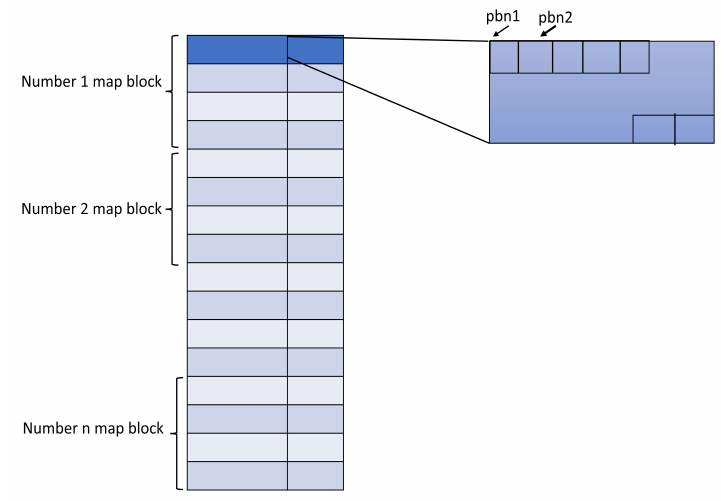
Figure 5. Map block